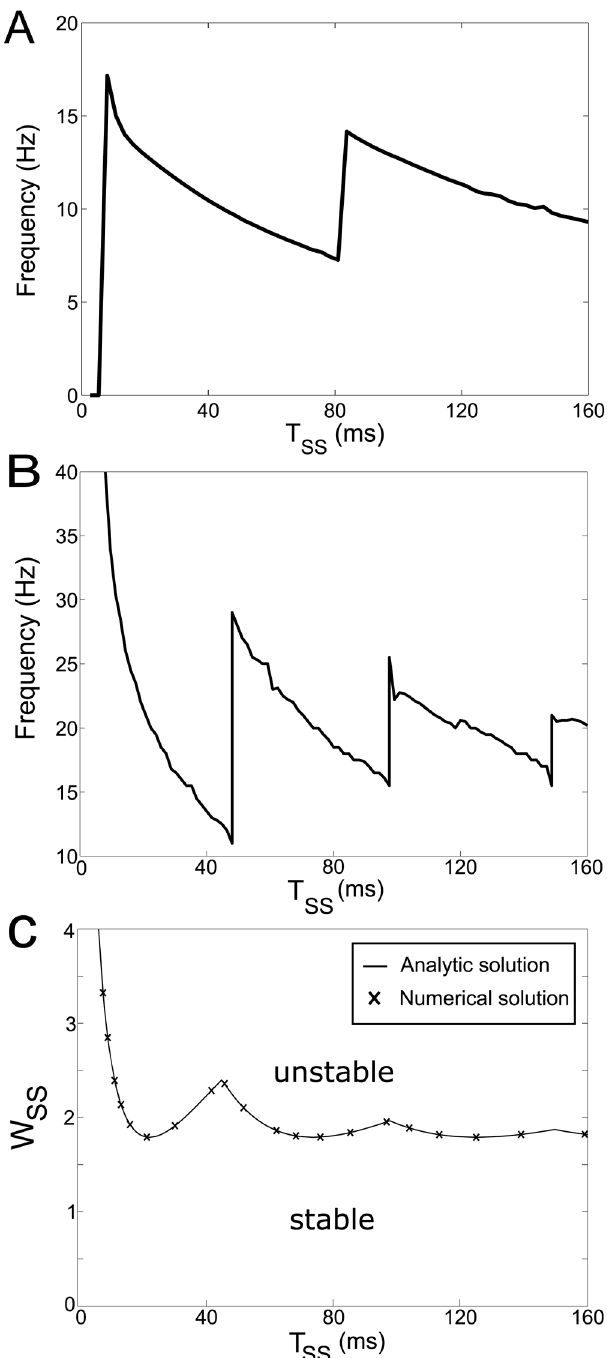
Fig 6. Effects of time delay in cortical feedback on model behaviour. A) The dependence of frequency in the feedback model on the delay in the long loop. B) The frequency range of oscillations produced by the linear system with delay only in cortical feedback for parameters that correspond to those along the stability boundary in panel C (i.e. for w SS slightly higher than the one at the stability boundary for a given T SS ). C) The stability boundary of the linear system with delay only in cortical feedback. The analytic solution (solid curve) is overlaid with the numerical solutions (crosses). When the system is in the parameter region above the stability boundary the STN-GPe circuit